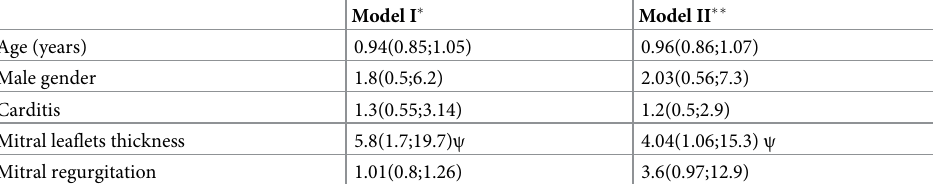
Table 3. Odds Ratio (OR) and 95% confidence interval for the variables included in Models I and